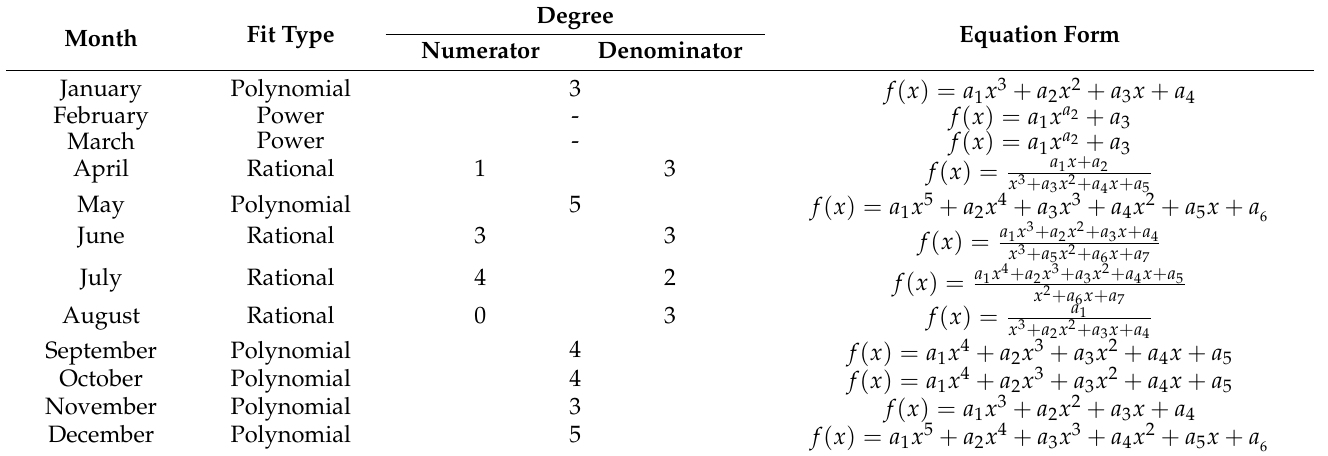
Figure A1. Monthly fitted FDC of Hongjiadu section. Table A1. Fit type and equation form of Hongjiadu section.